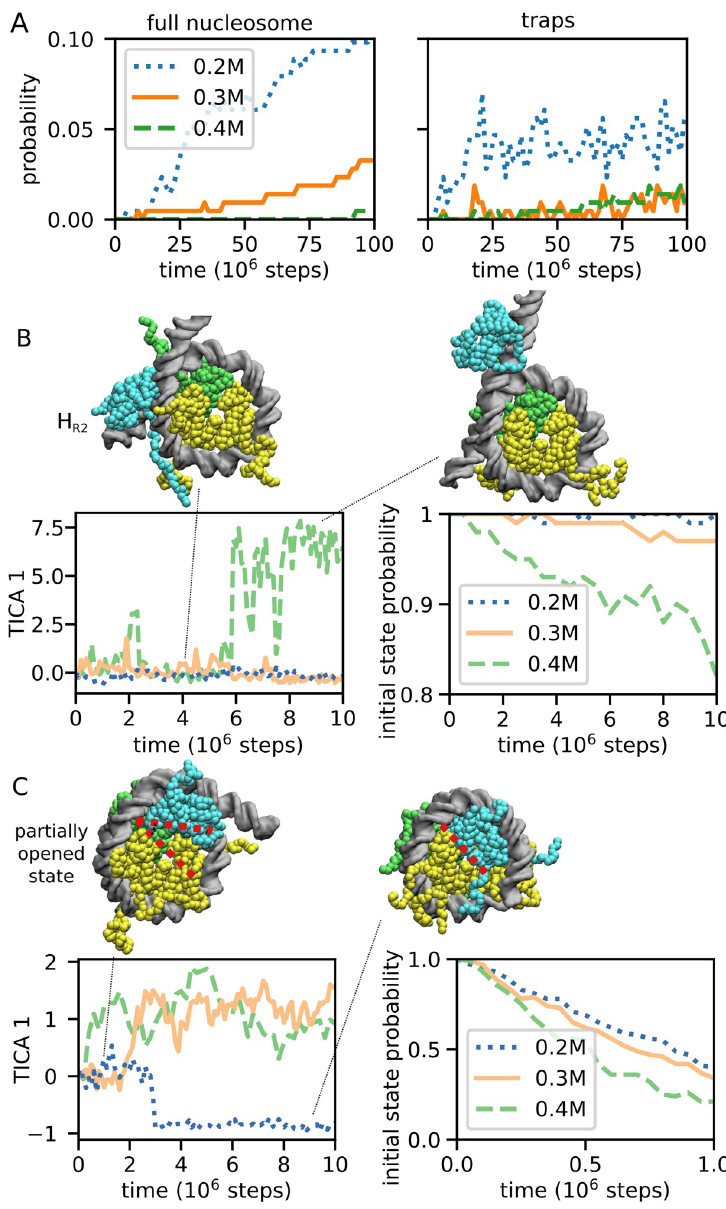
Fig 4. Salt-dependent assembly kinetics and escape from metastable states. (A) The time-dependent probability that, starting from a tetrasome, the system reaches either a full nucleosome (left panel) or one of the kinetic traps (right panel), which are defined as all the off-pathway conformations corresponding to the H R0 , H L0 , H R2 , H L2 and H R3 basins. (B) The escape kinetics from the H R2 kinetic trap. The left panel plots the timeline of the slowest characteristic coordinate, the first coordinate derived from time-lagged independent component analysis [42] (TICA 1, see Methods section for its definition) for a representative trajectory for each salt concentration. The right panel shows, as a function of time, the probability to remain the initial state, defined as the TICA 1 interval from -4 to +4, obtained from 100 trajectories (see Methods for more details). (C) The escape from the partially opened right hexasome identified during the successful hexamer-to-nucleosome assembly events. In order to highlight the conformational change, we indicate with two dotted red lines the wider angle between the unbound H2A/H2B dimer and the neighboring H3/H4 dimer, relative to that found in the fully assembled nucleosome. The left and right panels are the same plot as (B) except that the initial state is defined as the TICA 1 interval from -0.5 to 0.5. The time required to escape from these trapped states increases at low